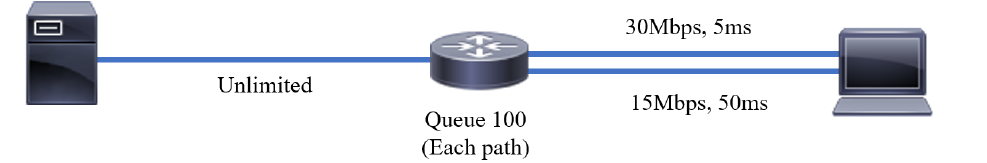
Figure 11. Network configuration to evaluate the chunk manager.